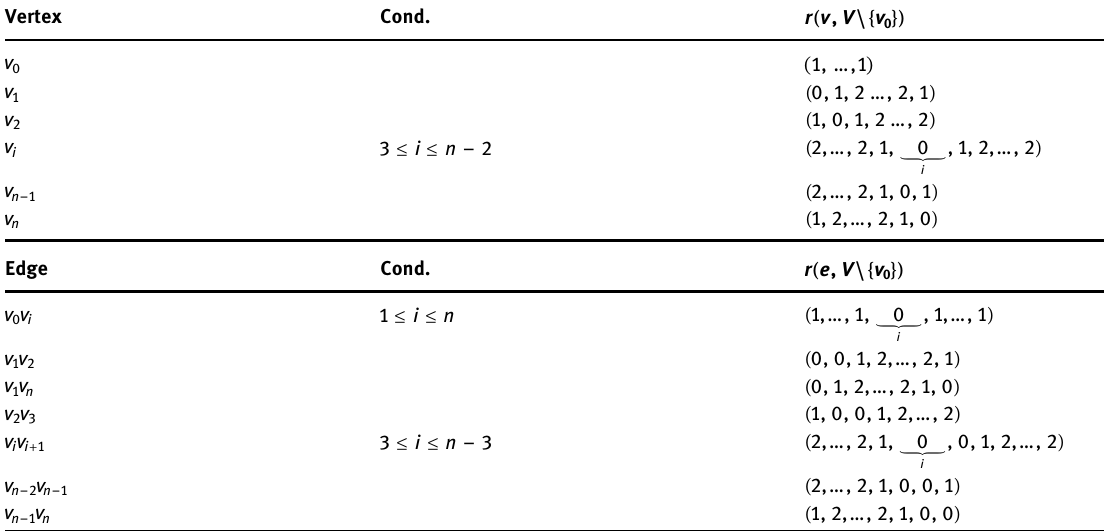
Table 4: Mixed metric representations for W n with respect to V v 0 { } ⧹ Vertex